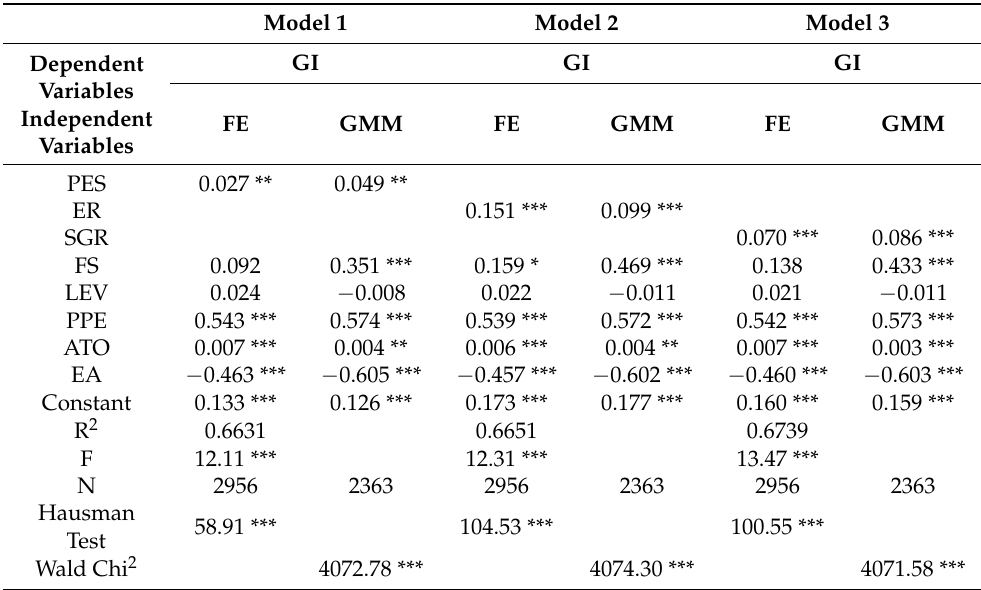
Table 3. Results of proactive environmental strategies, environmental regulations, and firm perfor- mance with green innovation.